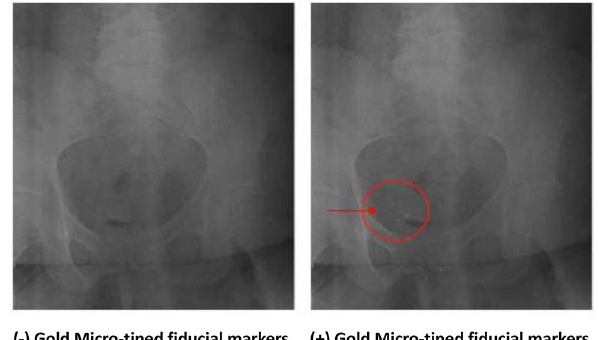
Figure 4. Plain-film X-Ray images of the pelvis without (left) and with (right) three 2.1 6 0.65 mm. 24K gold micro-tined fiducial markers surrounding the resection site of a right posterior-lateral bladder wall